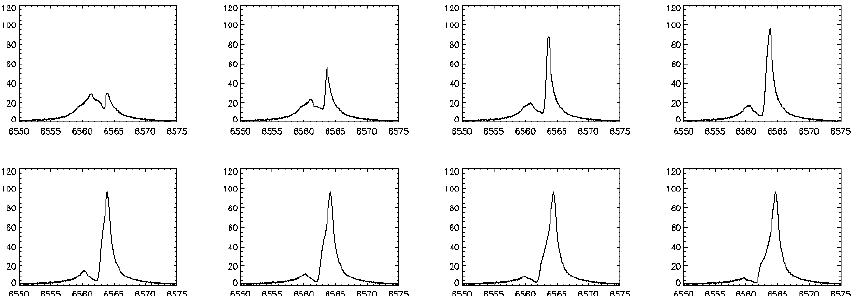
Fig. 7. Model line profile variations with orbital phase. A synthetic H α line, assumed to be a Gaussian, was absorbed in the wind of the RG assuming a terminal velocity of 30 km s (cid:0) 1 and a simple β -law (see the text). The mass ratio and orbital period approx- imately match BX Mon. Differential displacement (center-of-mass frame) produces the variability of the absorption feature. The emission line intensity was kept